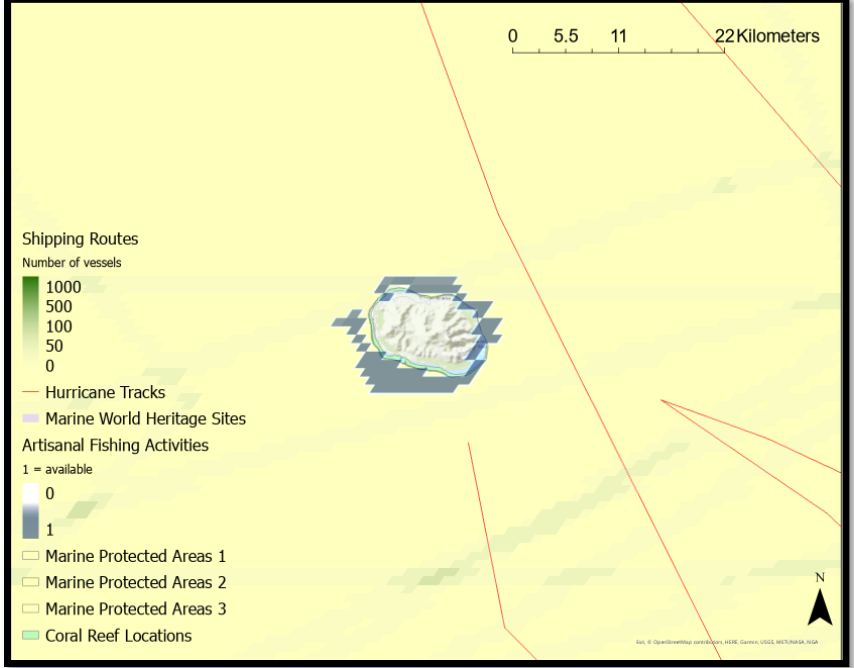
Figure 6. Map for Rarotonga demonstrating challenges found through spatial analysis. Color layers as per explained in Figure 4’s caption.